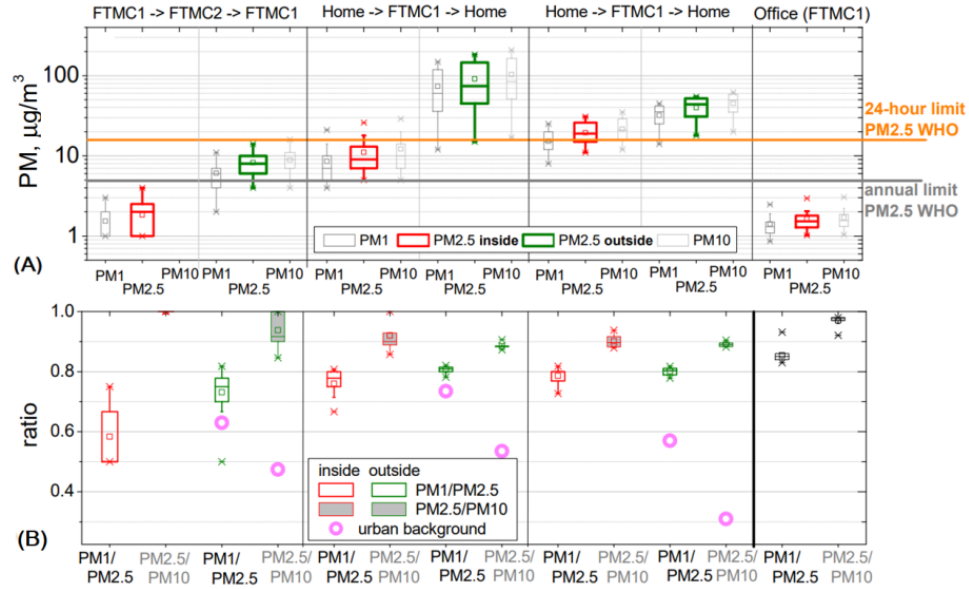
Figure 6. PM mass concentration and ratios of PM fractions: ( A ) statistics of mass concentration for all PM fractions inside (PM 2.5 red) and outside (PM 2.5 green) vehicle recorded while driving in Vilnius and in the office room; ( B ) ratios PM 1 /PM 2.5 (empty box) and PM 2.5 /PM 10 (filled light grey box). Whiskers: the 1st and 99th percentiles (error bars), quartiles Q 1 and Q 3 (box), median (horizontal line), and mean (square). PM ratios measured at the urban background station FTMC1 (APS) (purple circle).